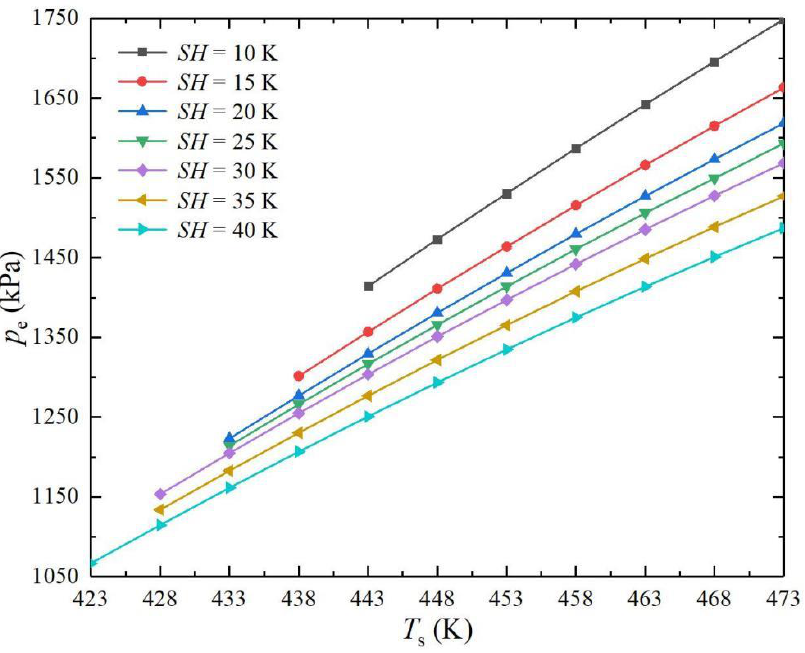
Figure 17. Evaporating pressure with heat-source temperatures under different superheat degrees.